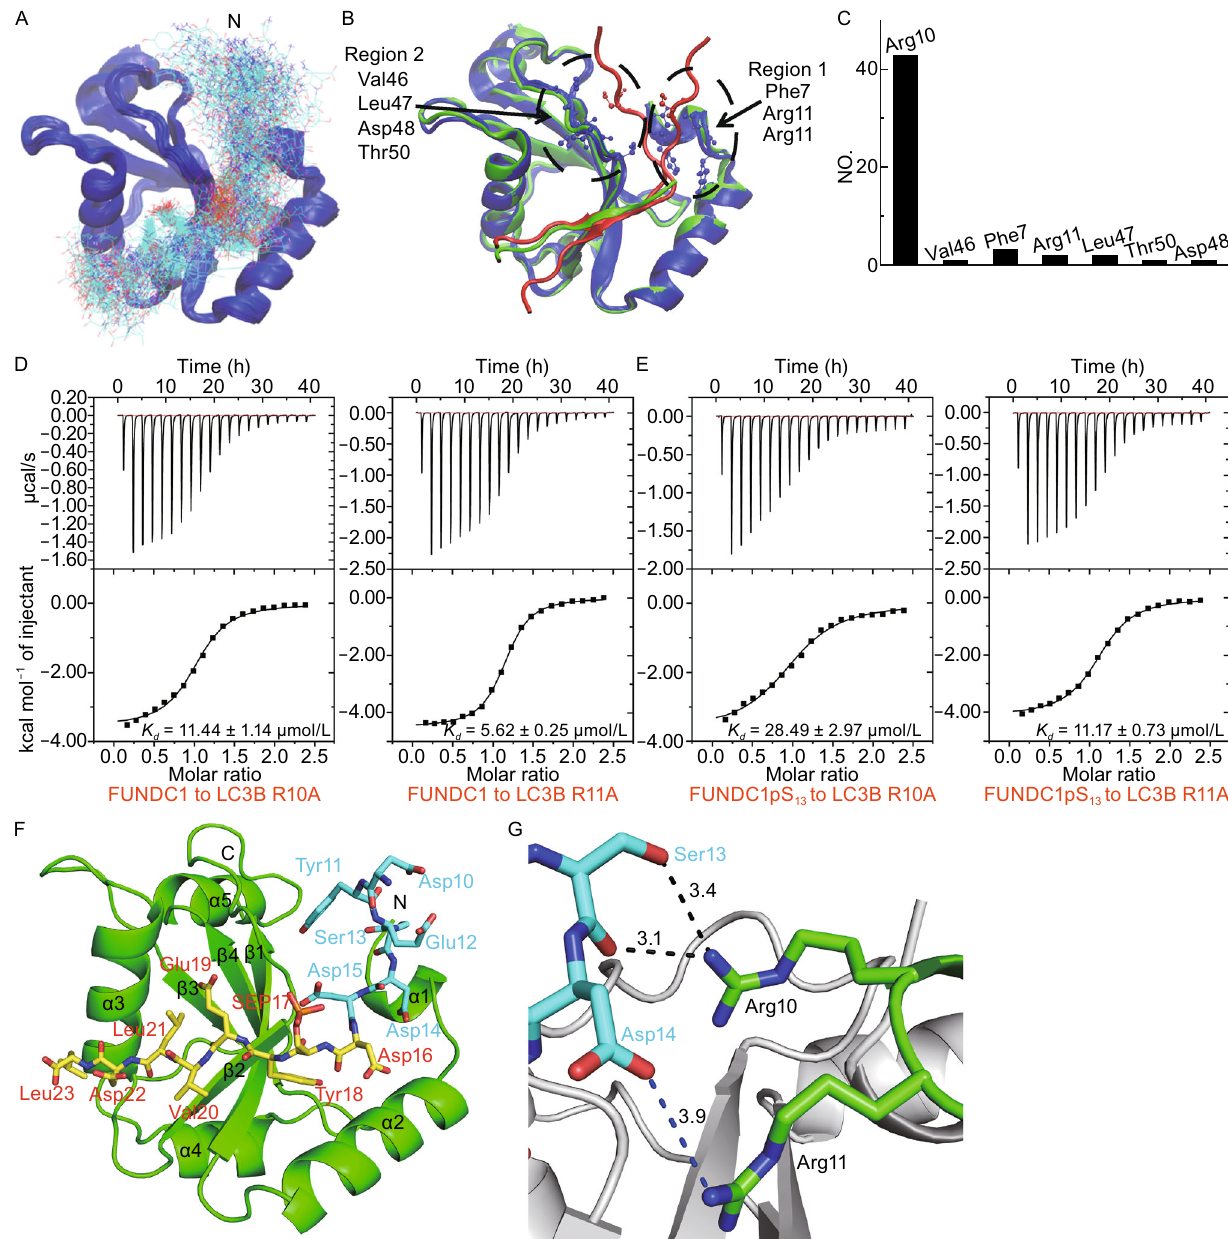
Fig. 6. The HADDOCK model of LC3B-FUNDC1 10 – 23 complex. (A) The initial 200 models of the LC3B-FUNDC1 10 – 23 complex calculated by HADDOCK. LC3B is colored blue and the FUNDC1 pS 17 peptide is colored cyan. The N-terminus of the FUNDC1 pS 17 peptide is marked. (B) The two most possible regions calculated from the statistics of initial HADDOCK models. Our crystal structure is shown in green and the calculated models are colored in blue and red, respectively, and labeled in black. (C) The statistics of the most probable LC3B residues interacting with FUNDC1 Ser13. (D and E) The ITC fi tting results of FUNDC1 unphosphorylated peptide and pS 13 peptide with LC3B mutants at the Arg10 and Arg11 positions. (F) The possible model of the LC3B-FUNDC1 10 – 23 complex calculated by HADDOCK. LC3B and FUNDC1 pS 17 peptide 16 – 23 are shown in green and yellow, respectively. The N-terminus of the FUNDC1 pS 17 peptide 10 – 15 is colored and labeled in cyan. (G) The possible interactions of LC3B Arg10 and Arg11 (green) with Ser13 and Asp14 (cyan) of FUNDC1 pS 17 peptide. Hydrogen bonds and electrostatic interaction are indicated as black and blue dashes,